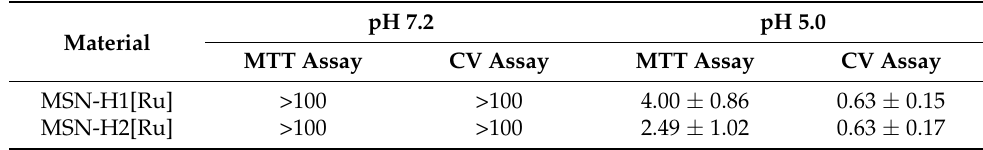
Table 3. MC 50 1 values [ µ g/mL] of the B16F1 cells treated for 48 h with MSN-H1[Ru] or MSN-H1[Ru].